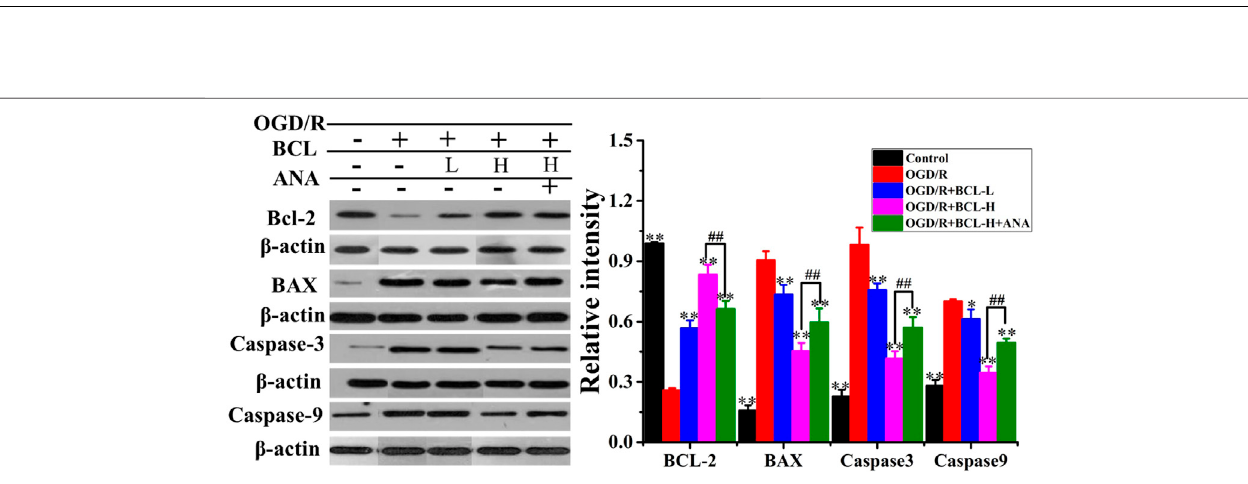
Frontiers in Pharmacology |